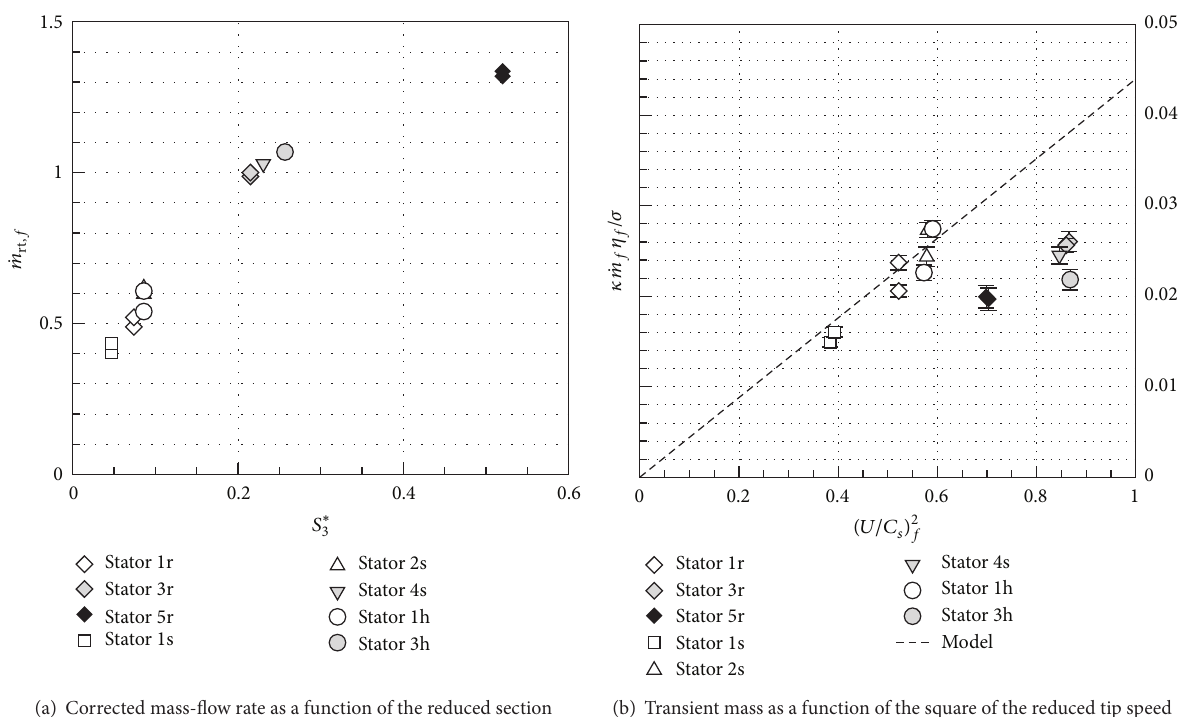
differ geometrically (see [6] for more details). The